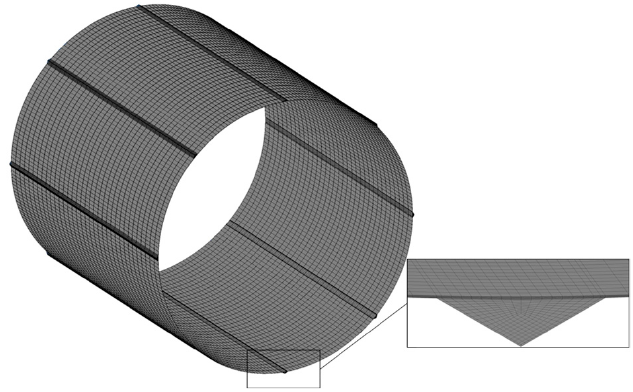
Figure 4. Mesh for Fluent.